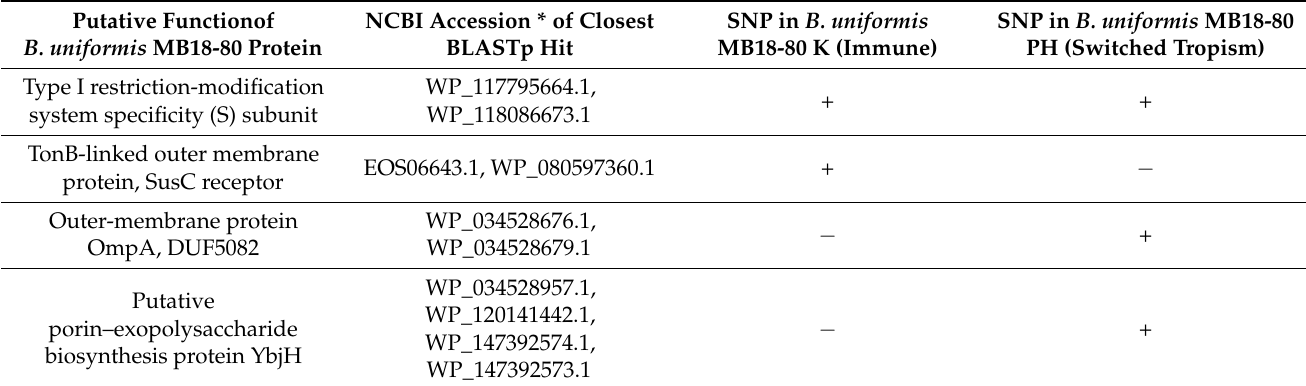
Table 3. Genetic differences in Bacuni phage F4 host MB18-80 derivatives that are immune to infection with Bacuni phages or indicate a tropism switching